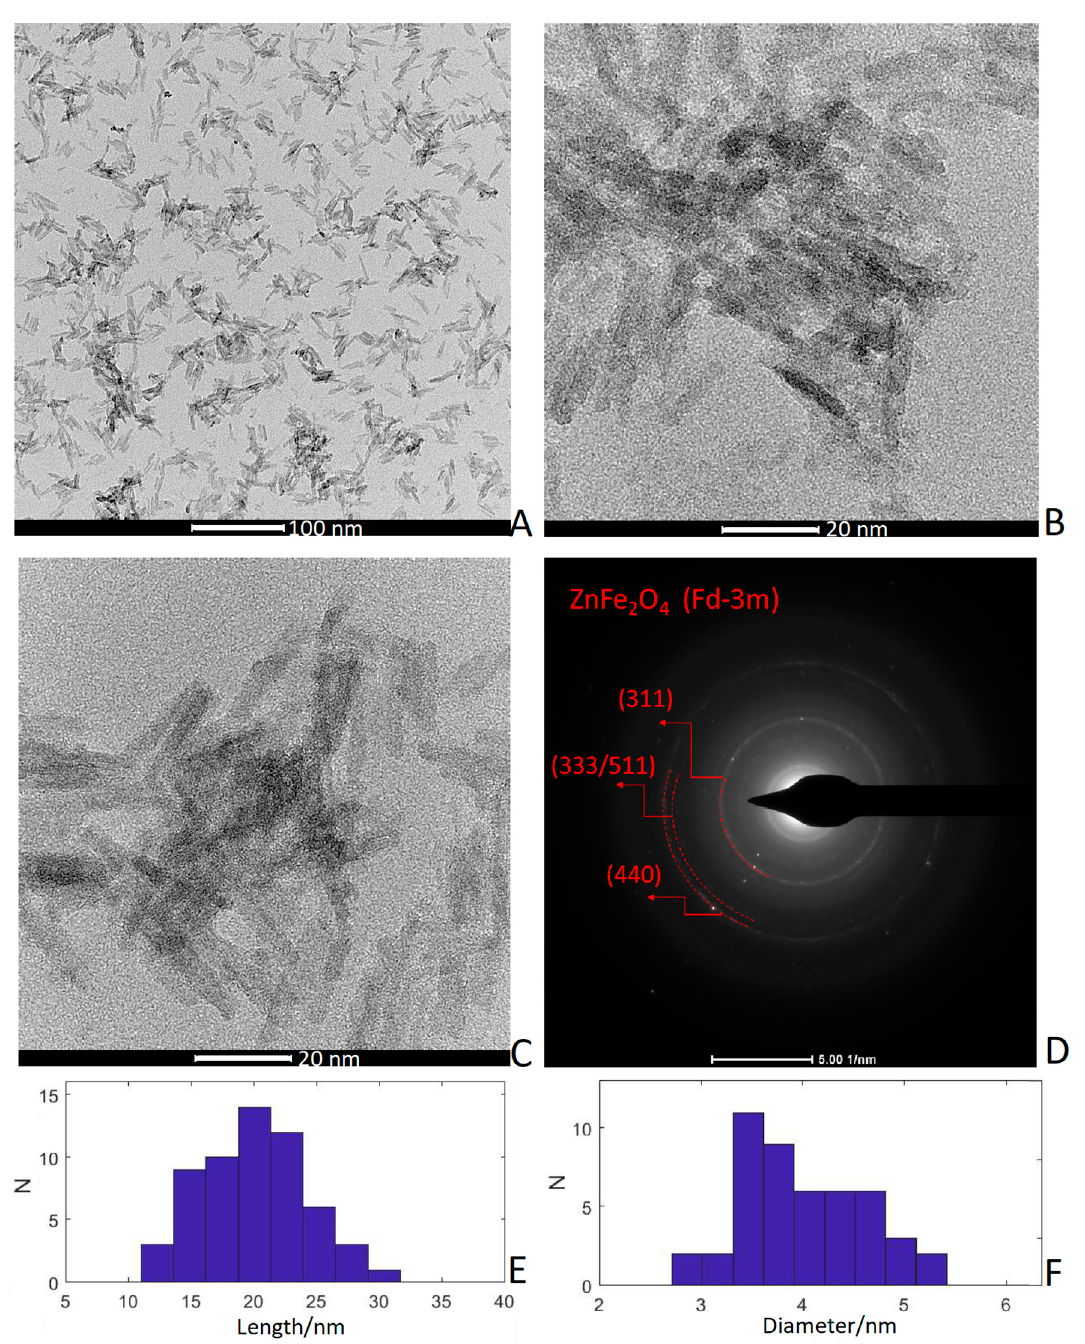
Figure 2. ( A – C ) TEM images of zinc ferrite nanorods, ( D ) their selected-area electron diffraction (SAED) pattern, ( E and F ) histograms respectively for length: mean = 19.9 nm, std/mean = 22% and for width mean = 4.02 nm, std/mean = 16%.